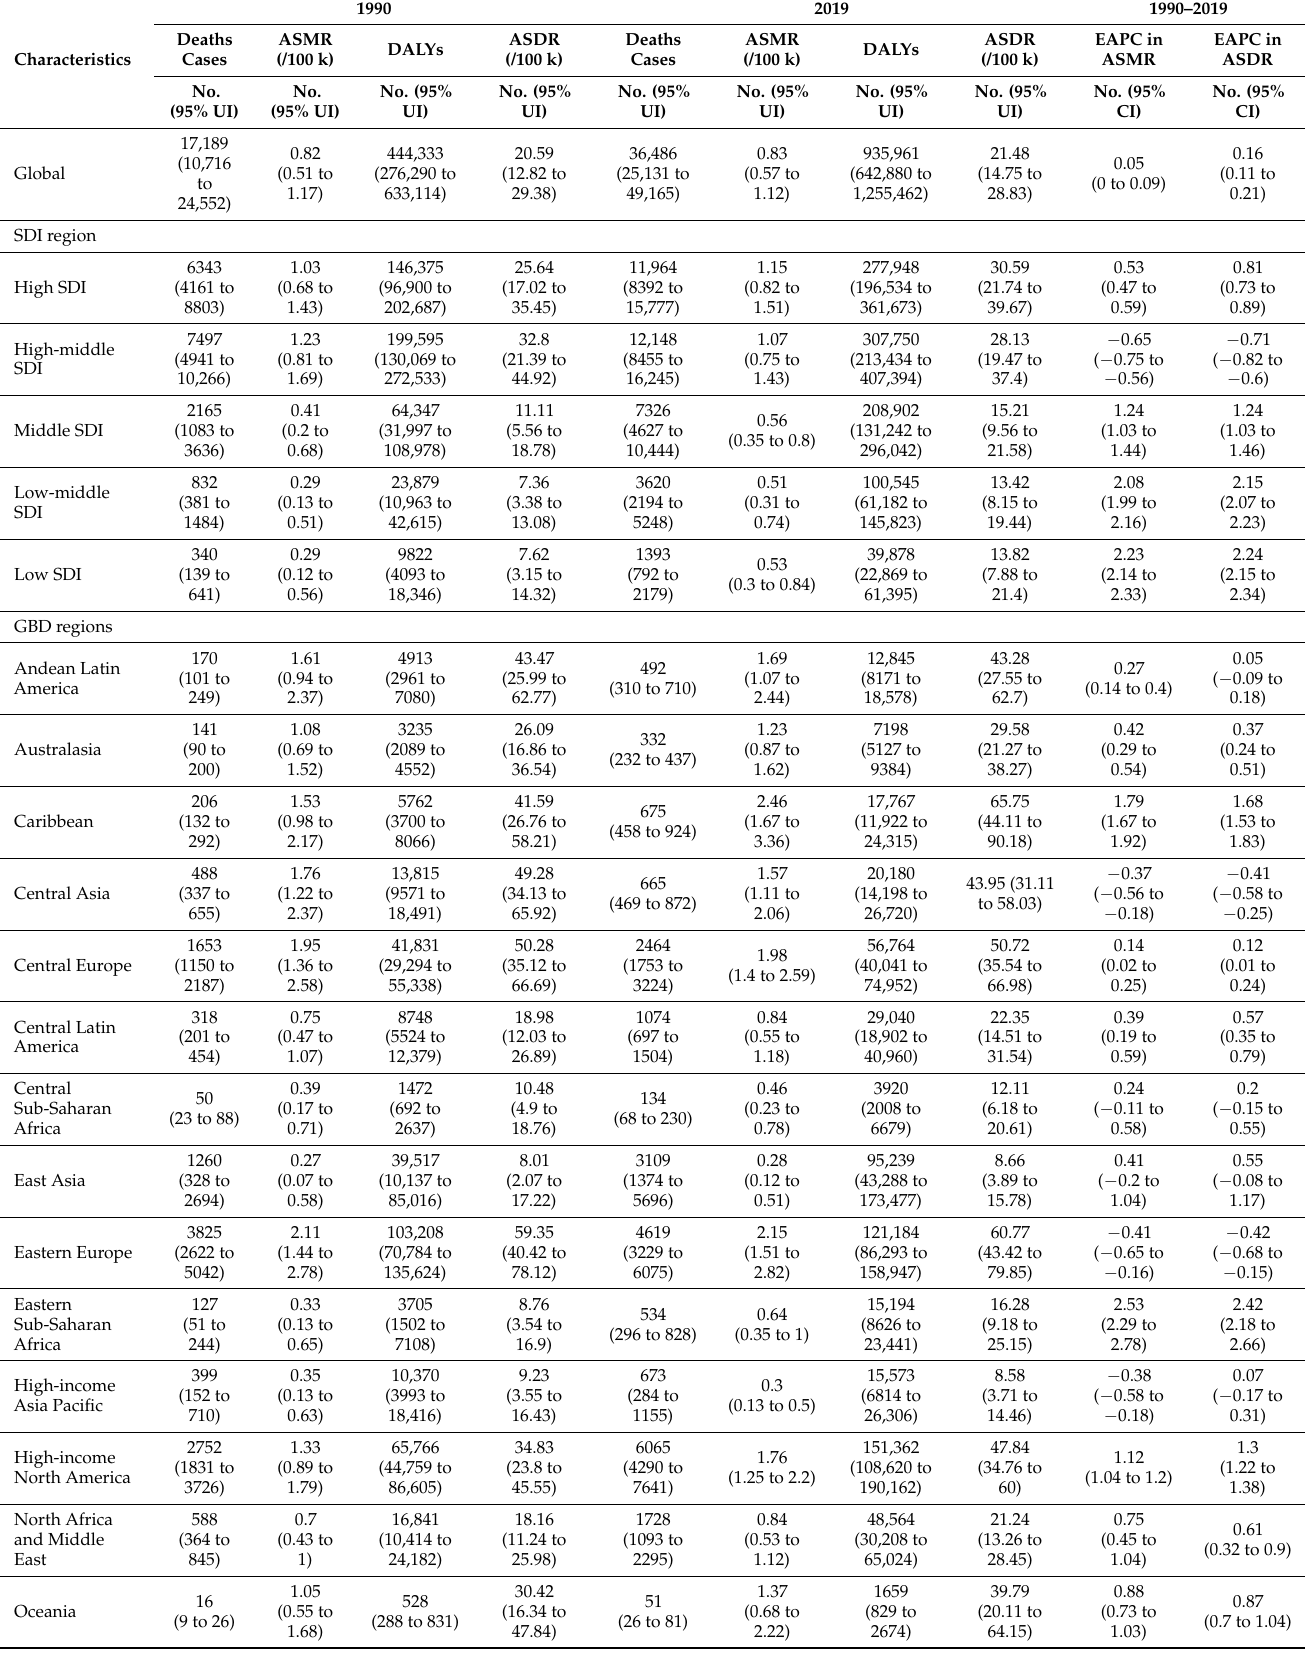
Table 1. Burden of uterine cancer attributable to high BMI in global, SDI regions, and GBD